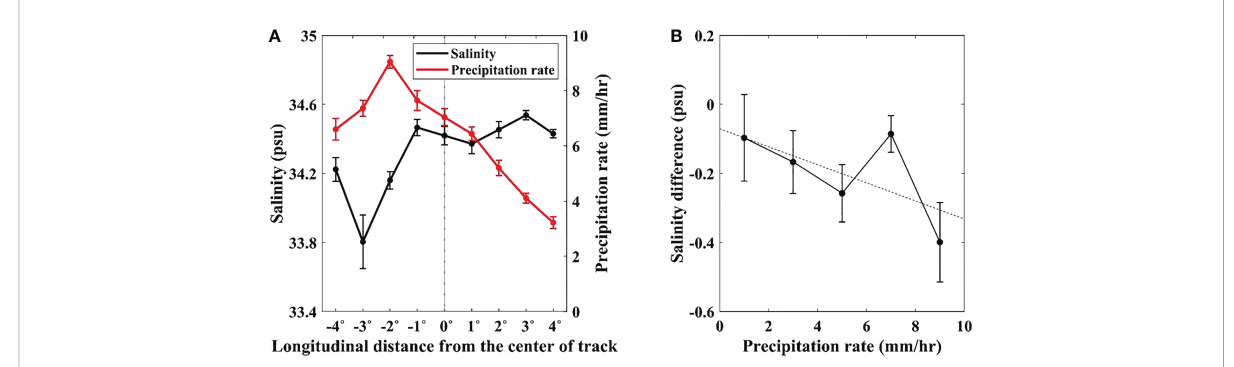
FIGURE 11 (A) Zonal distribution of sea surface salinity (a black line) (°C) and precipitation rate (a gray line) (mm h -1 ) across Typhoon Wipha track at a cross section within a range of 10 – 20 °N, 130 – 150 °E, and (B) relationship between satellite salinity difference (after minus before the arrival of Typhoon Wipha) and precipitation